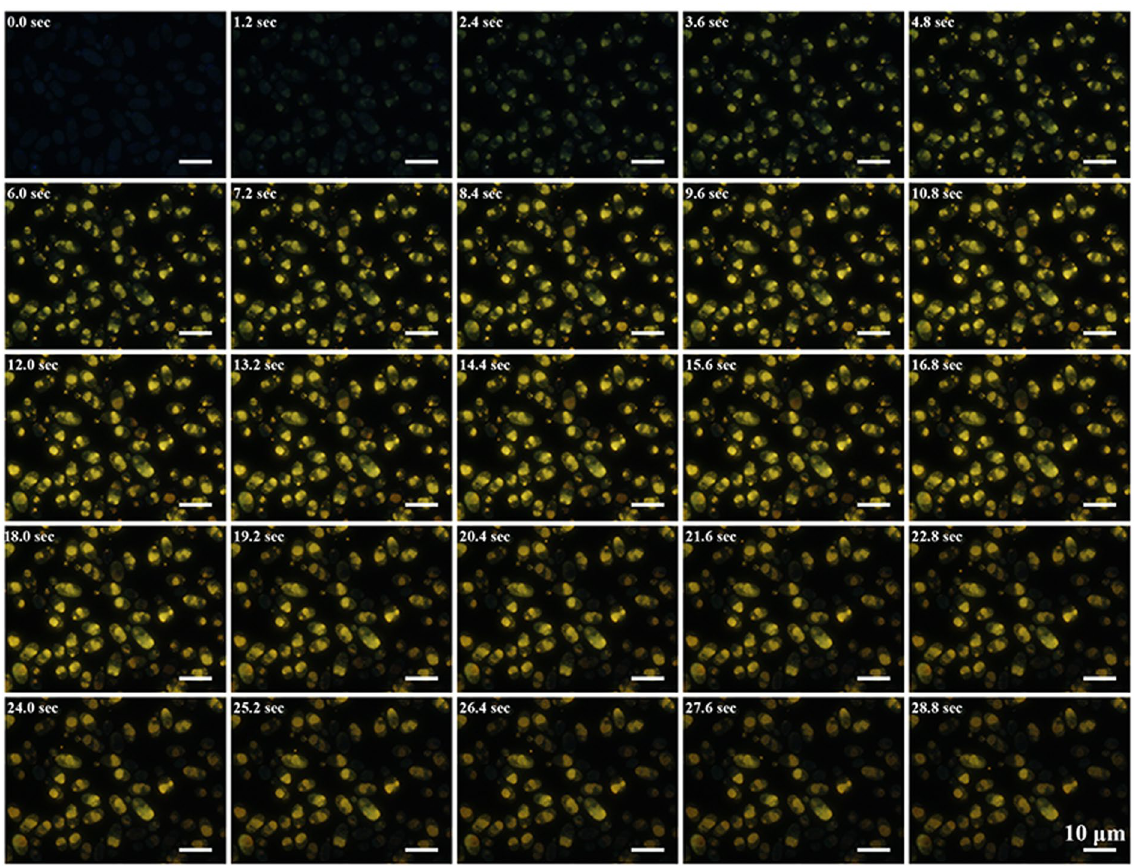
Figure 2. Time series fluorescence microscopy images of the cells to show the fluorescence evolution of the bio- QDs in vivo . The cells were grown in medium with 1 mM Na 2 SeO 3 and 2 mM CdCl 2 . The time interval between two images was 1.2 second. Video was taken from a 150- μ m 2 area where there were at least 80 cells.